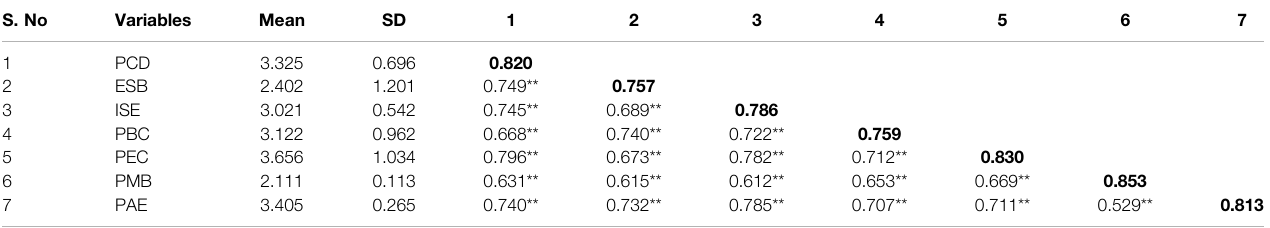
1990). This study fi nds the value of SRMR is 0.077 and NFI is 0.617, suggesting our model is relatively satisfactory. Next, the GoF formula was used to calculate the model fi t (Henseler and